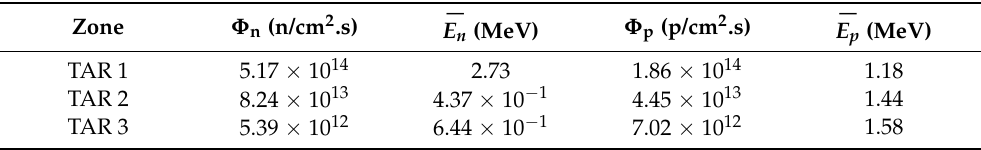
Table 9. Total neutron/photon flux densities and average neutron/photon energies at the incident surfaces of the three target segments.